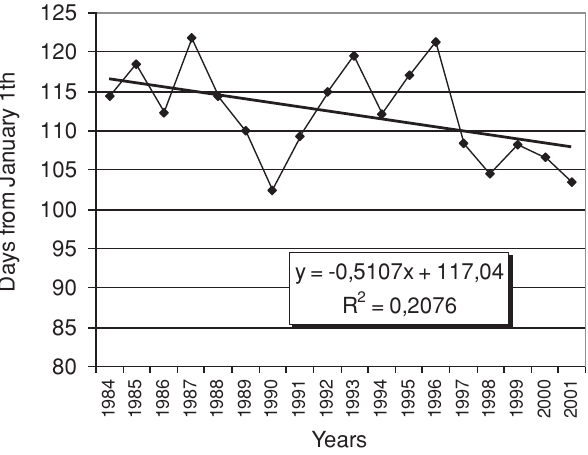
Figure 1. Distribution of the beginning of blooming time in dry and humid